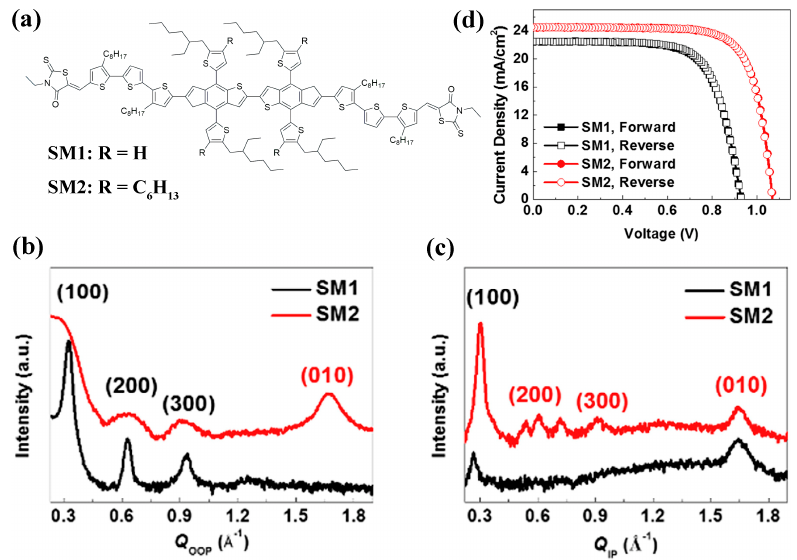
Figure 7. ( a ) Molecular structures of SM1 and SM2. The line-cut profile of HTMs from 2D GIWAXS patterns in the ( b ) out-of-plane (OOP) and ( c ) in-plane (IP) direction. ( d ) J - V curves of SM-based devices measured under forward and reverse voltage scans (forward direction: from 0 V to forward bias, reverse direction: from forward bias to 0 V). Adapted with permission from Ref. [103]. Copyright 2020 Elsevier.